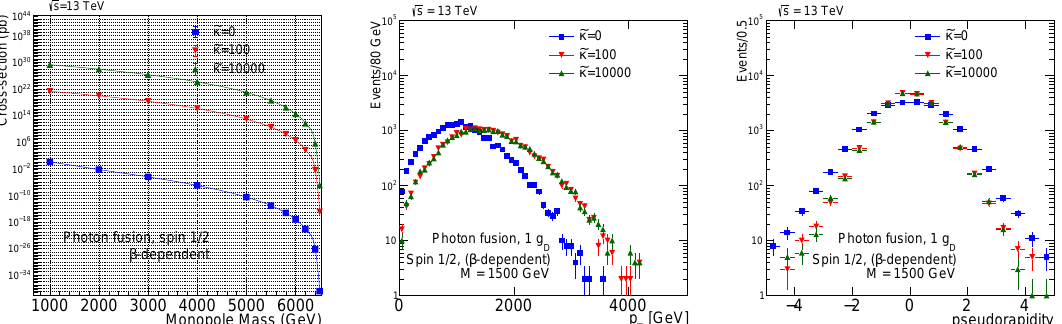
Figure 6. The cross-section variation with the monopole mass at a proton-proton collision energy of 13 TeV is shown on the left plot for the spin 1 / 2 monopoles. The transverse momentum ( p T ) distribution ( middle ) and pseudorapidity distribution ( right ) are shown for the spin 1 / 2 monopole at a proton-proton collision energy of 13 TeV [10].